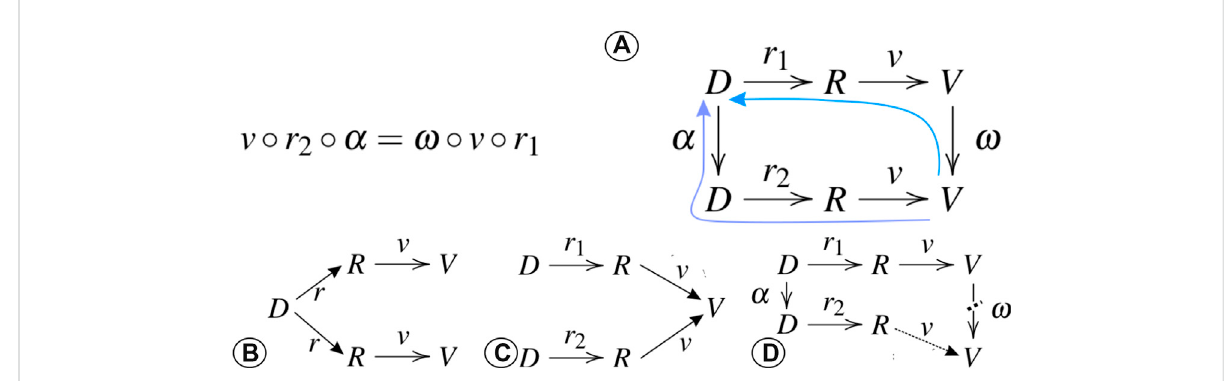
FIGURE 1 Algebraic visualisation design: adequate visualisations adhere to the commutative rules of representation and visual mapping in (A) . If the same data map (without a change in α or ω ) to different visual expressions, the visualisation has a hallucinator that compromises invariance (B) . If multiple, different data map to the exact same visual expression (without a change in α or ω ), the visualisation is affected by a confuser that makes the visualisationambiguous (C) .Ifachangeof α correspondstoadisproportionatevisualmappingchangein ω ,theresultingjumblershowsalackof correspondence in the visualisation (D)